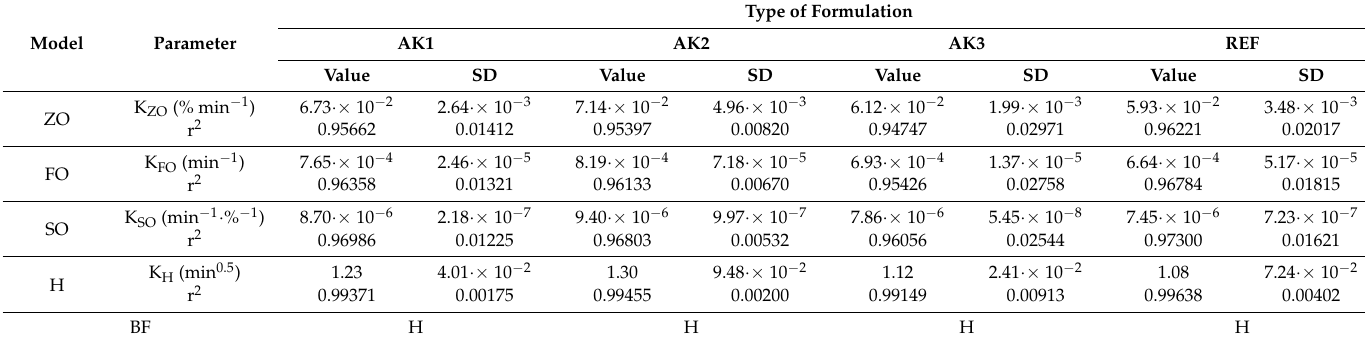
SD—standard deviation; BF—best